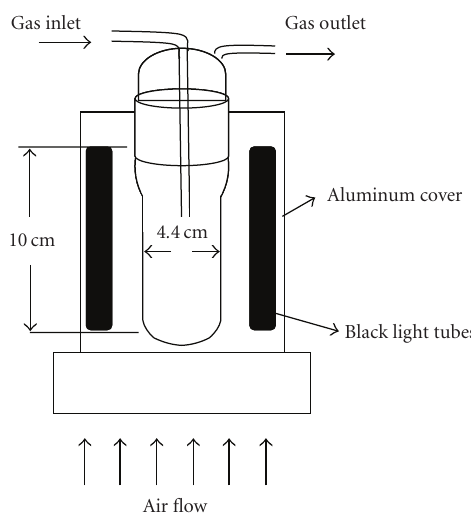
Figure 1: Schematic representation of the reactor used in all ex-